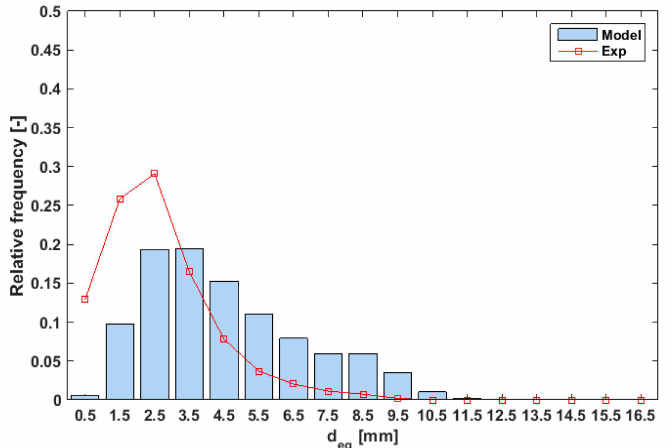
Figure 15. Comparison between PBM results and experimental data: Martinez constant and uniform BSD at the inlet: U G = 0.0111 m/s.